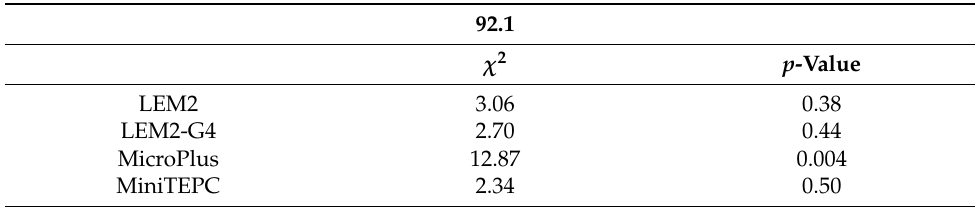
Table 5. Results of the χ 2 test for the comparison of the experimental survival curves of 92.1 cells against the survival fraction calculated with the LEM II, Geant4 coupled with LEM II and the Loncol’s function applied with the microdosimetric spectra obtained with the two detectors. The correspond- ing χ 2 probabilities are calculated for four degrees of freedom.